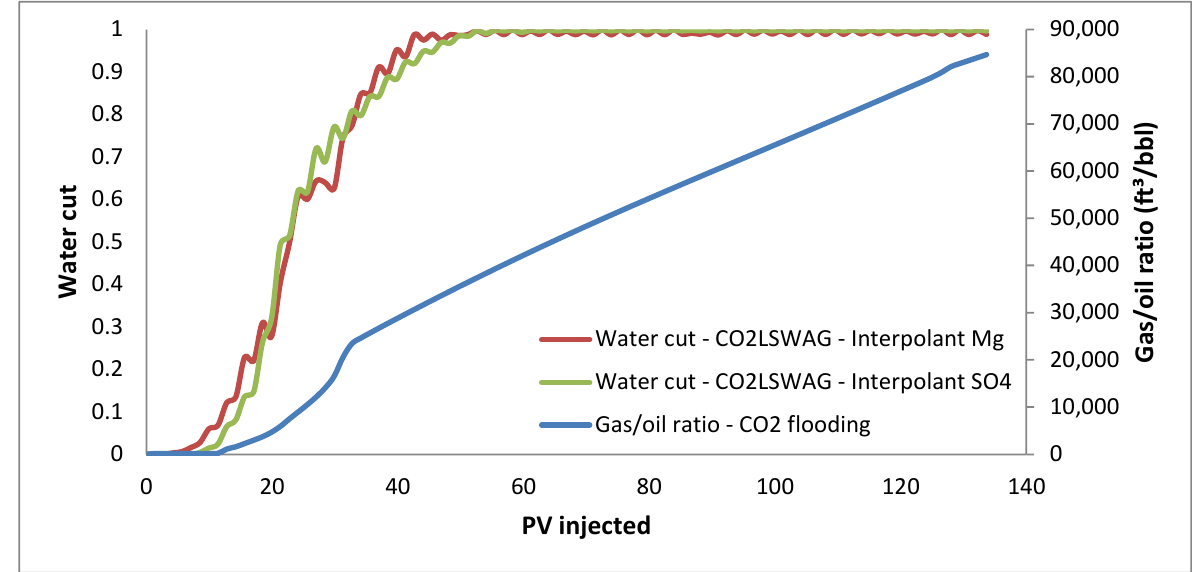
Figure 5. Water cut for CO 2 -LSWAG considering Mg and SO 4 as interpolant ions and gas – oil ratio for continuous CO 2 injection.